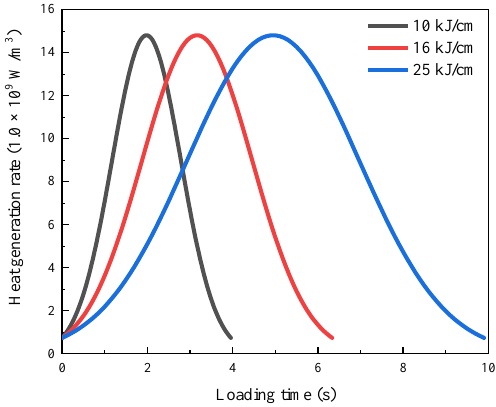
Figure 8. Time distribution of heat generation rate under different linear energy.